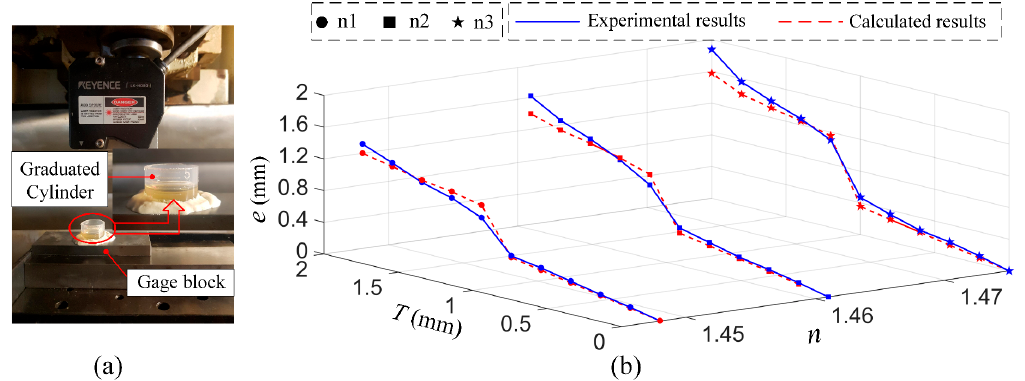
Figure 9. ( a ) The measurement experiment with the presence of an oily substance on the measured object; ( b ) comparative results for both the experiment and